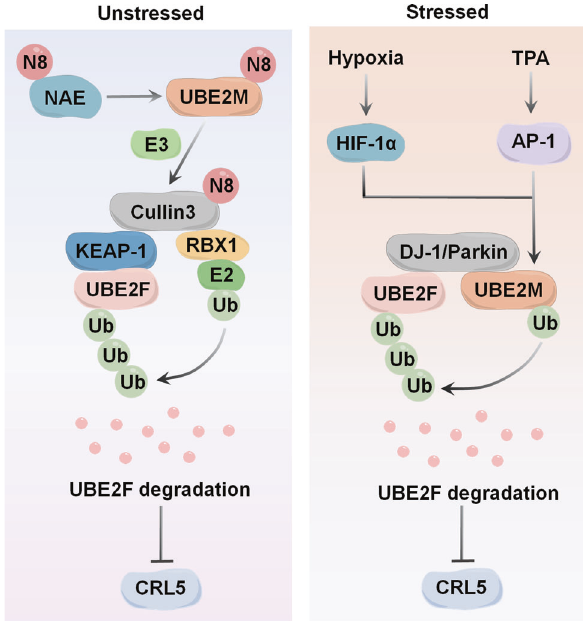
Fig. 2 UBE2M acts as a dual E2 for neddylation and ubiquitylation to degrade UBE2F. Under physiological conditions, UBE2M serves as a neddylation E2 to promote CUL3 neddylation, triggering polyubiquitylation and degradation of UBE2F through CUL3-KEAP1 E3 ligase. Under stressed conditions, UBE2M is transcriptionally activated by HIF-1 α or AP-1, which makes it serve as a ubiquitylation E2 to complex with DJ-1/Parkin to promote the ubiquitylation and degradation of UBE2F. Ultimately, the degradation of UBE2F is accompanied by the inactivation of CRL5. TPA: a typical tumor promoter and mitogen stimulator, inducing